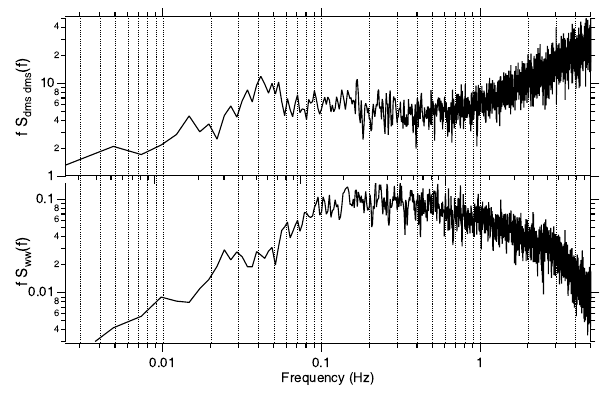
Fig. 4. Variance spectra for DMS (top) and vertical wind ve- locity ( w , bottom) plotted in log f S xx (f ) vs. log f format. The negative slope of the inertial subrange apparent in the w spec- trum is not a feature of the DMS spectrum due to the white noise contribution. Spectra are 1h averages. u r ≈ 14ms − 1 . F dms ≈ 4.4µmolesm − 2 d − 1